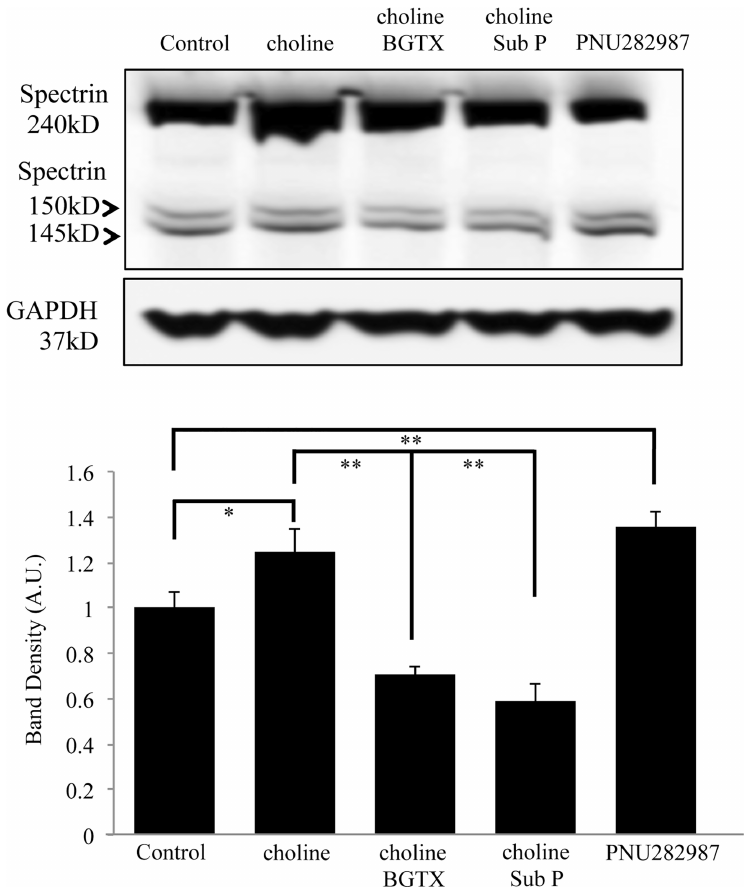
Fig 6. Pharmacological α 7 nAChR activation mediates spectrin breakdown. Top, a western blot showing anti- α IIspectrin immunoreactive bands at 240 kD, 150 kD, and 145 kD. Lanes were loaded with lysates from PC12 cells treated with choline (10 mM) (choline), choline 10 mM) with BGTX (50 nM) or Sub P (1 μM), or PNU282987 (10 μM). Vehicle (HBSS) was used as the Control. Bottom, band density analysis from four independent experiments showing an effect of drug treatment on α IIspectrin breakdown. ( (cid:3) = p < 0.05 (cid:3)(cid:3) = p < 0.005, (cid:3)(cid:3)(cid:3) = p < 0.001; n = 4 independent experiments).